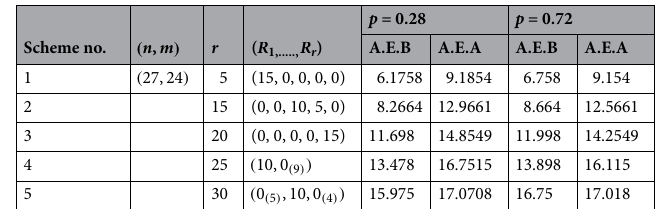
Table 4. The comparison between A.E.B and A.E.A for real data.